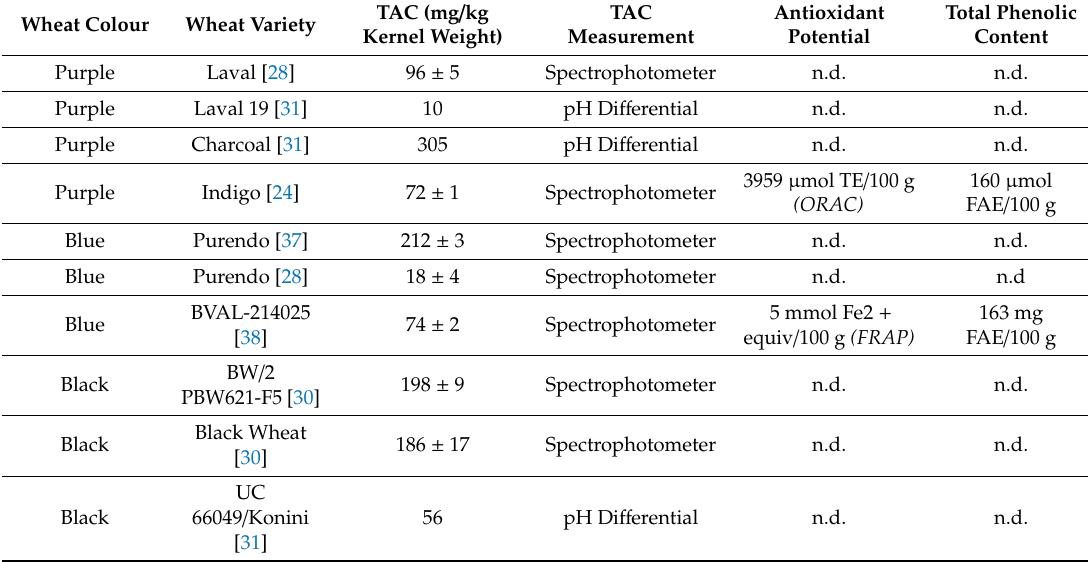
Table 1. Selection of studies focusing on total anthocyanin content (TAC) in various wheat cultivars. The anthocyanin quantification method and assay used for antioxidant potential are also